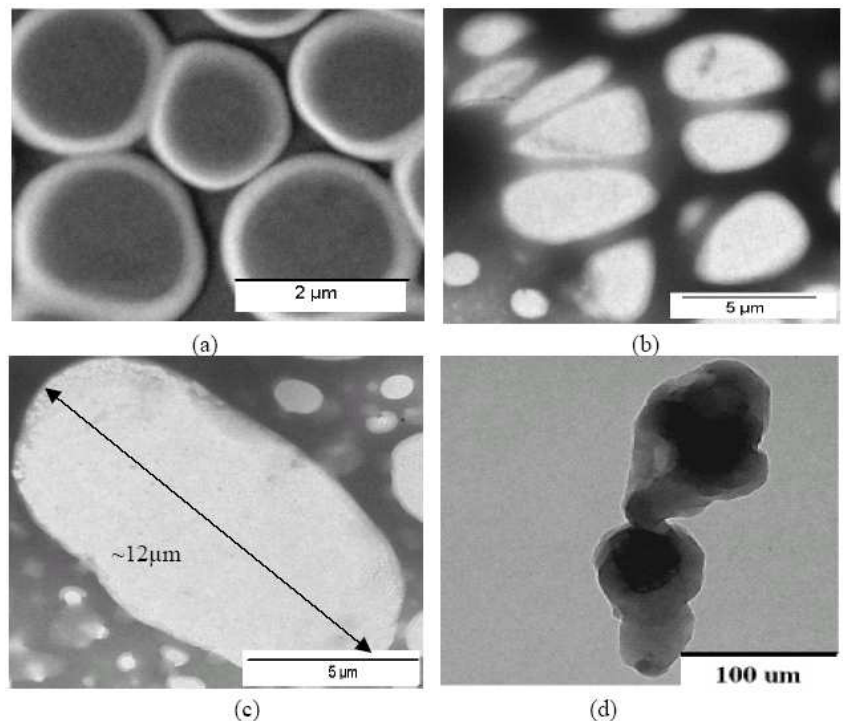
Figure 3. Transmission electron microscopy images of a) 20 KDa, b) 50 KDa, and c) 65 KDa self doped Pani, and d) non-self doped